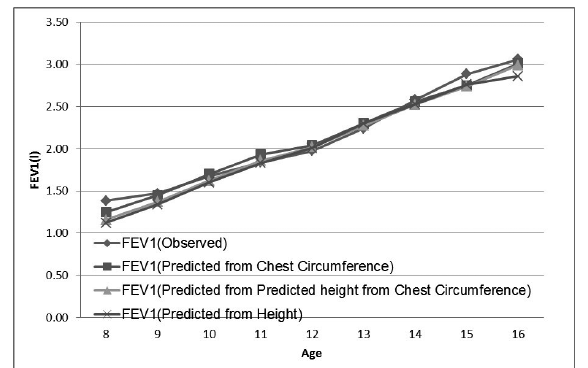
Figure 1b. Comparison between observed/measured FEV1 values vs predicted values from eqautions based CC (P = 0.93), height derieved from CC (P = 0.11) and height (P =